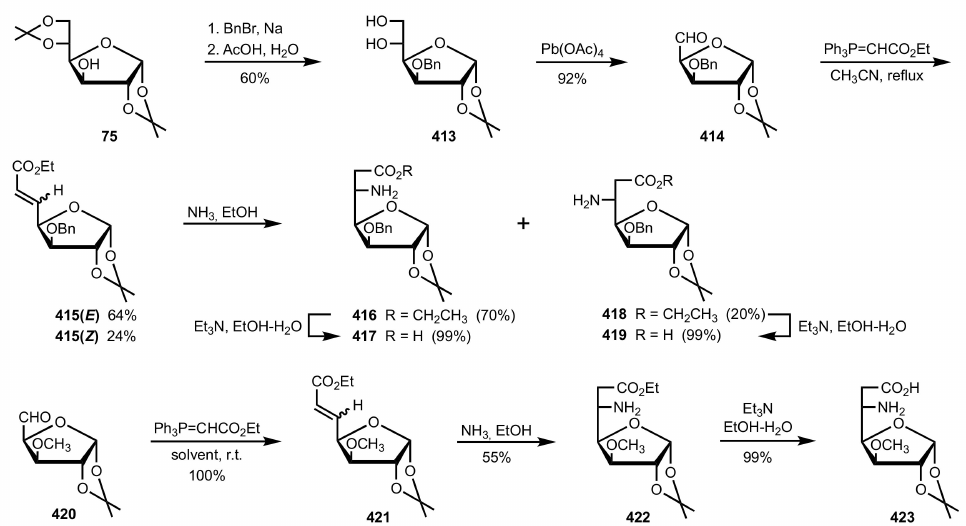
Scheme 113. The synthesis of the sugar aminoacid organocatalysts 416 , 417 , 419 and 423